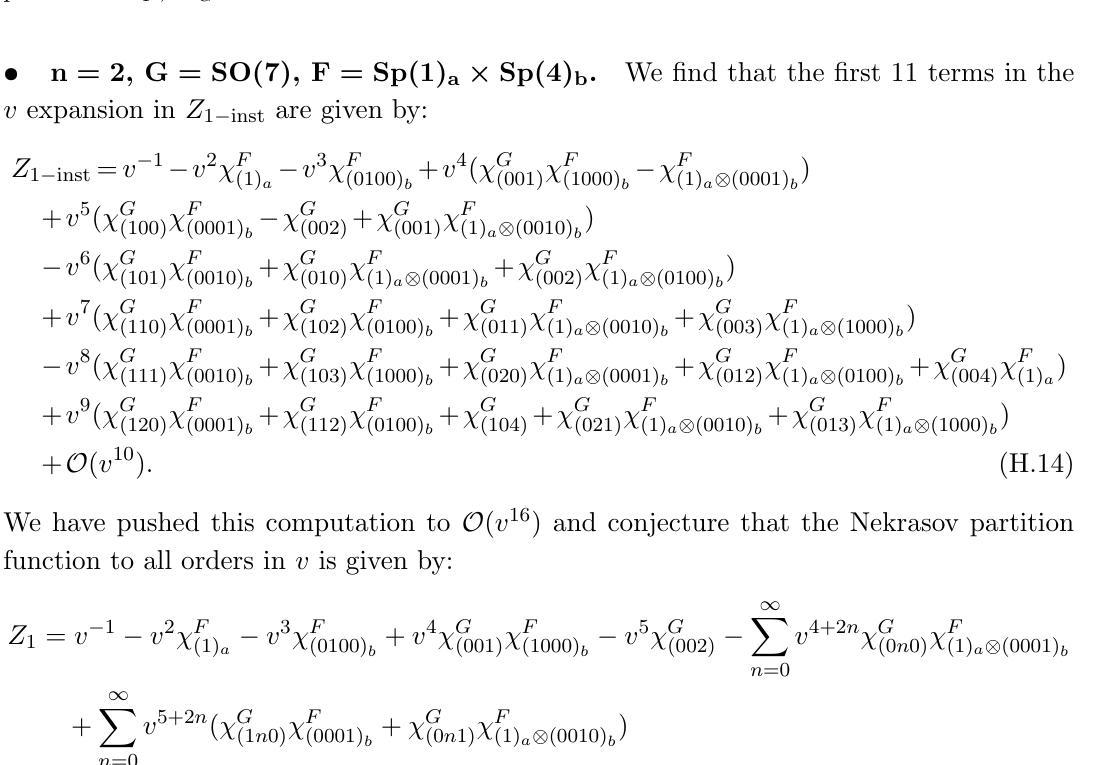
Table 92. 5d limit of the one-string elliptic genus for the theories h G potentials m F ; m G turned